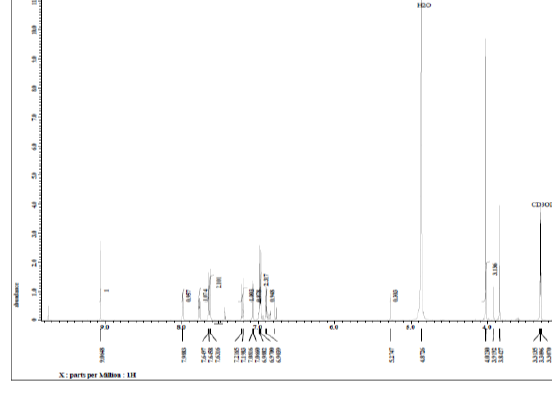
Figure 3. Spectra of 1 H-NMR Table I. The interpretation of 1 H-NMR